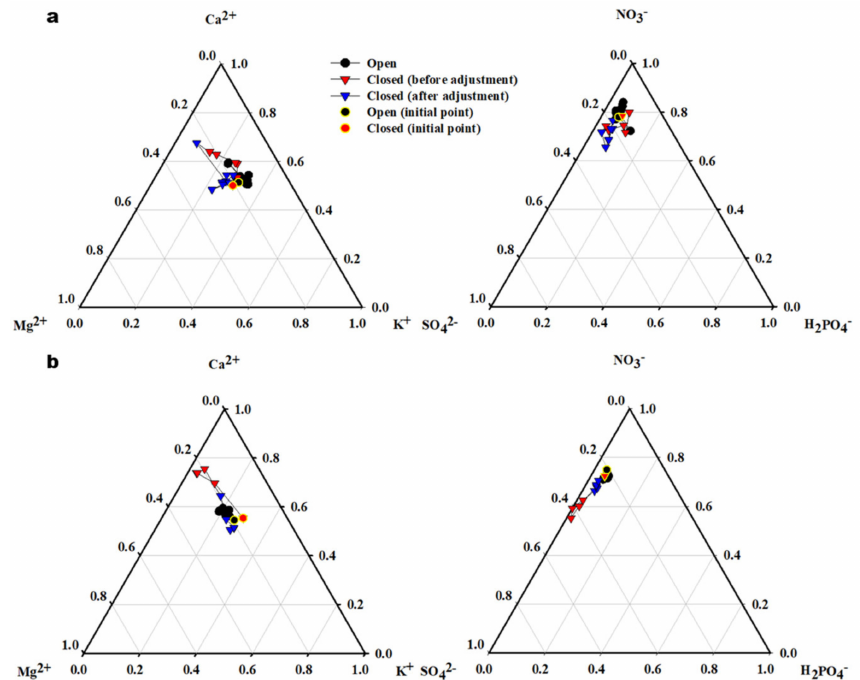
Figure 4. Changes in ion balance under the nutrient balance control in the experimental- ( a ) and commercial- ( b ) scale